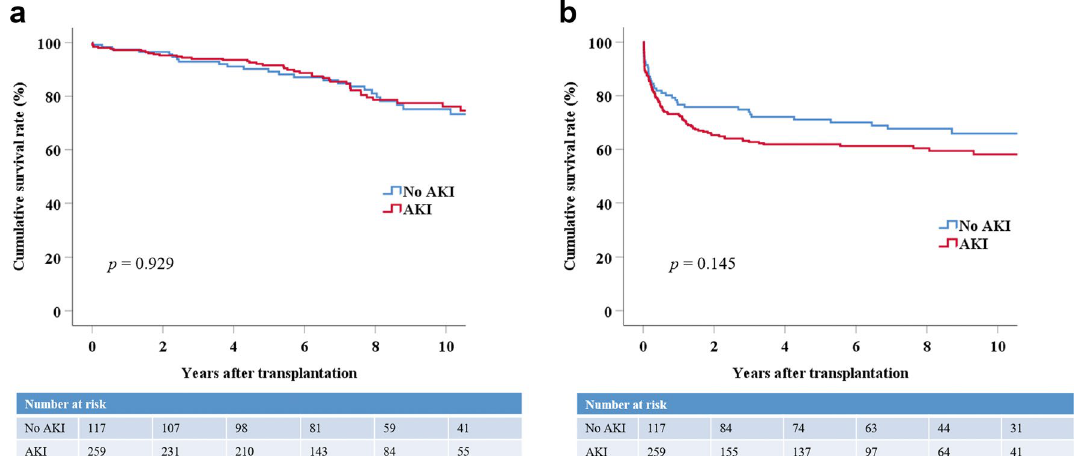
Figure 1. Death-censored and rejection-free graft survival between the No AKI and AKI groups. ( a ) Death- censored graft survival between the No AKI and AKI groups. Group comparisons were performed using the Kaplan–Meier and log-rank tests. ( b ) Rejection-free graft survival between the No AKI and AKI groups. Group comparisons were performed using the Kaplan–Meier and log-rank tests. AKI acute kidney